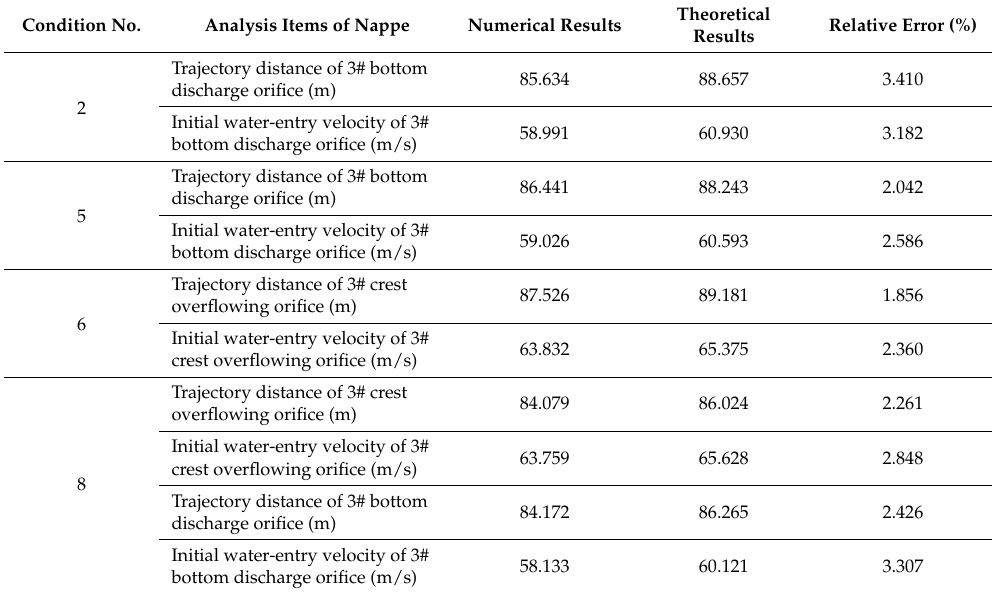
Table 3. Comparison between theoretical and numerical